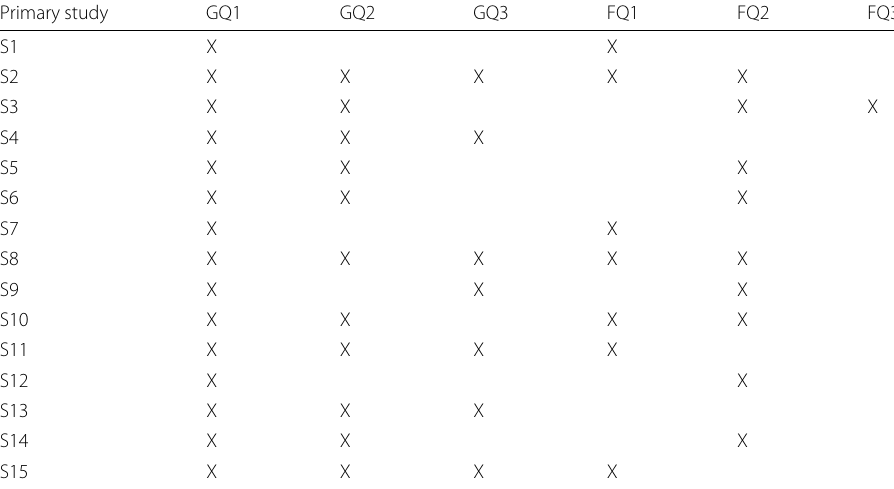
Table 9 Data extraction from primary